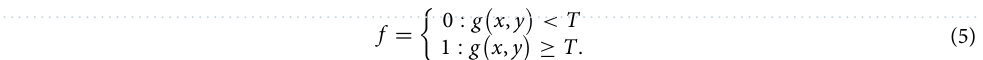
Figure 4. ( a ) is the image of a sample without any mAb (blank). ( b ) and ( c ) show two images of aggregates of various sizes at 4 × and 10 × magnifications and ( d ) is 4 × magnified image showing large sized